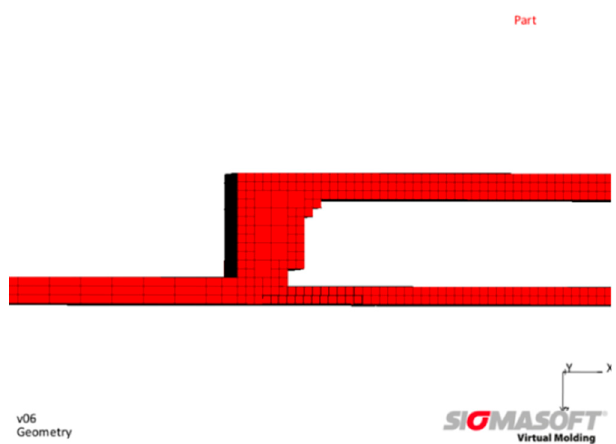
Figure 5. Exemplary fine mesh around the MLF with at least three elements over the wall thickness.